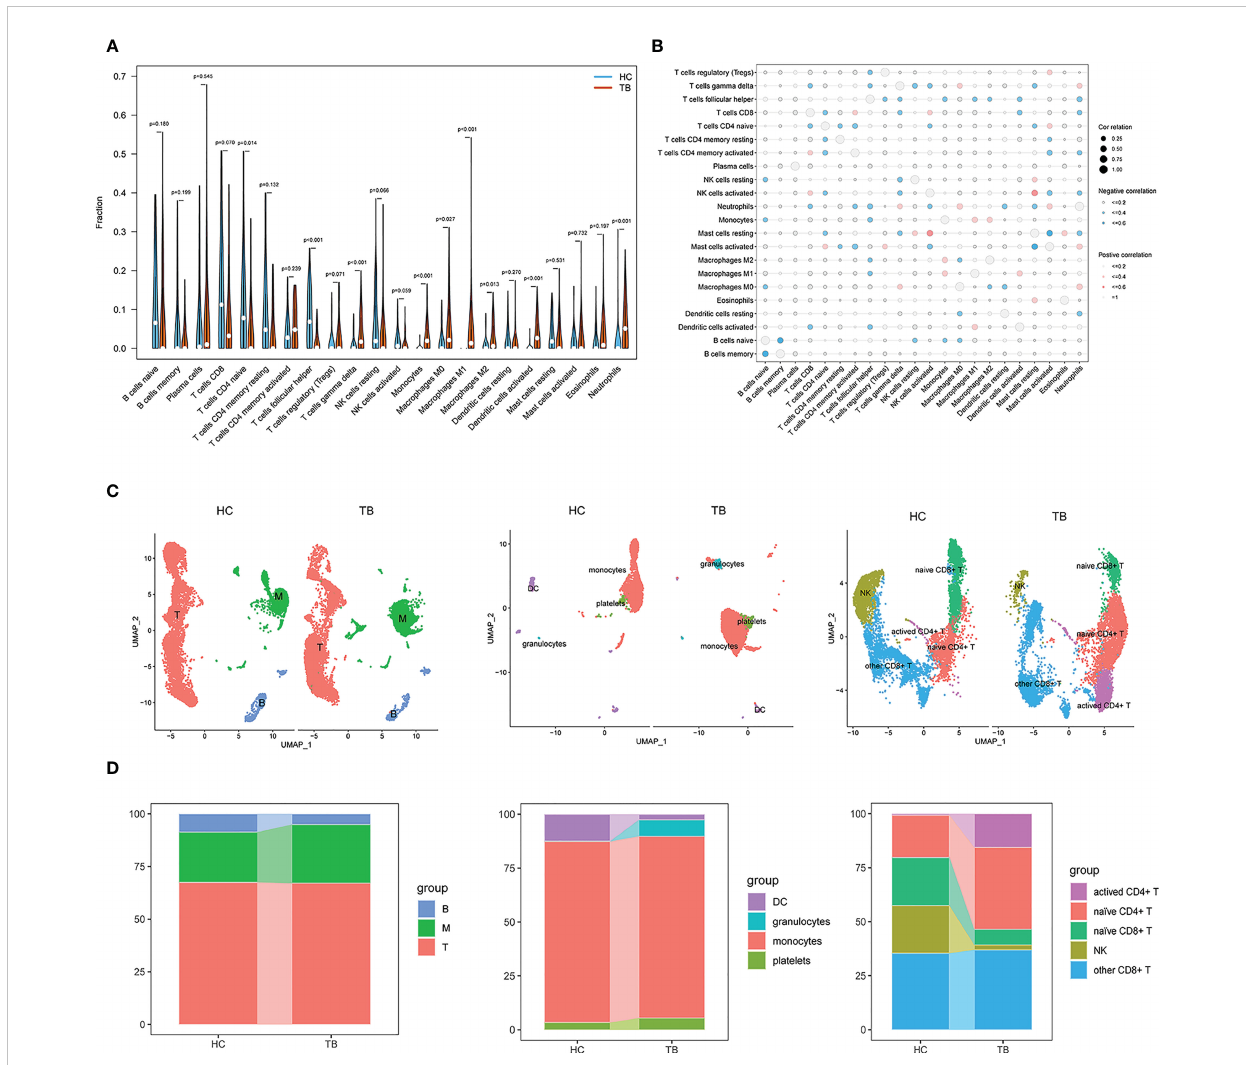
FIGURE 3 Immune cell enrichment in patients with TB. (A) Comparison of 22 immune cell subtypes between patients with TB and HCs. (B) Correlations among all 22 analyzed immune cell subtypes. Size and coloration of the circles are proportional to the corresponding Pearson correlation coef fi cients. (C) UMAP visualization of major cell types across three groups (left), Myeloid clusters (middle), and T cells (right). (D) Proportion of each de fi ned cell type across major groups (left), Myeloid clusters (middle), and T cells (right). B, B cells; T, T cells; M, Myeloid. NK, Naturel